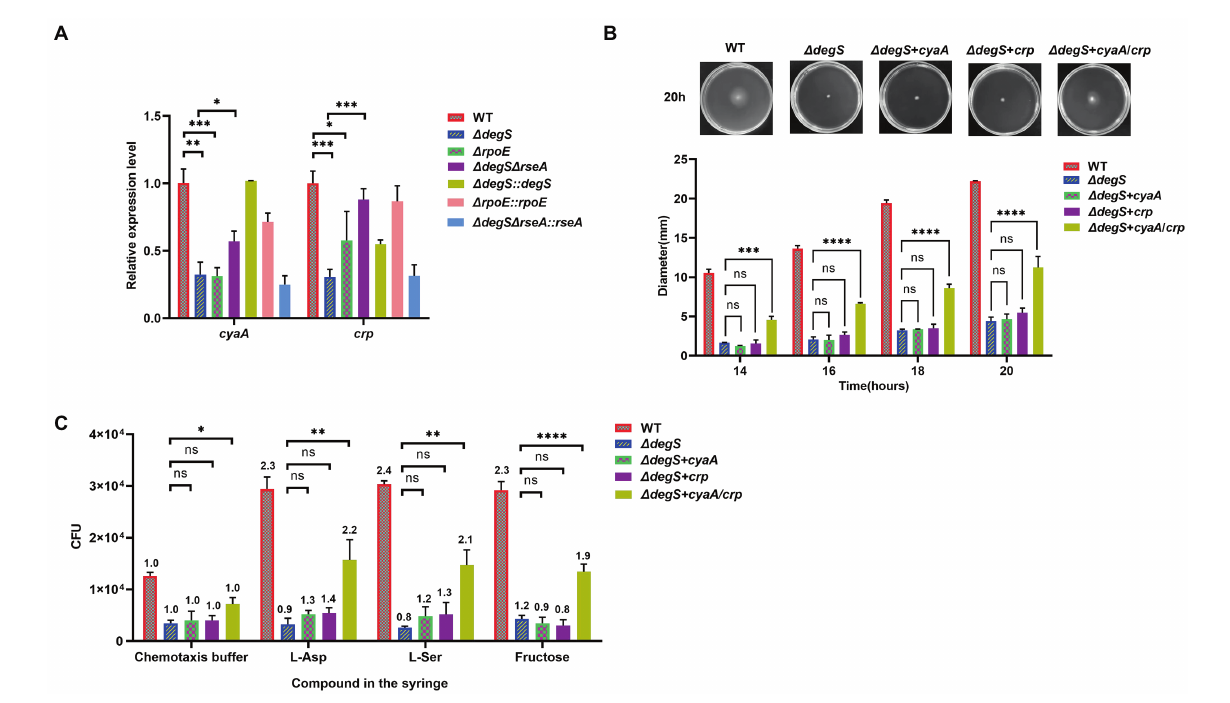
FIGURE 2 The regulation of Vibrio cholerae motility by DegS may involve the co-regulation of cAMP and CRP. (A) The mRNA levels of cyaA and crp in the WT, Δ degS , Δ degS::degS , Δ rpoE , Δ rpoE::rpoE , Δ degS Δ rseA , and Δ degS Δ rseA::rseA strains. Statistical analyses were performed using an unpaired t -test. *, p < 0.05; **, p < 0.01; and ***, p < 0.001 between two strains. (B) The swimming motility of WT, Δ degS , Δ degS + crp , Δ degS + cyaA and Δ degS + cyaA / crp strains was determined. The representative pictures for the swimming zones are obtained at 20 h. Statistical analyses were performed using a two-way ANOVA. ***, p < 0.001 and ****, p < 0.0001 between two strains; ns, not significant. (C) Analysis of the chemotactic responses to aspartate, serine, and fructose for the WT, Δ degS , Δ degS + crp , Δ degS + cyaA , and Δ degS + cyaA / crp strains. Error bars indicate the SDs based on three replicated experimental values (n = 3). *, p < 0.05; **, p < 0.01; and ****, p < 0.0001 between two strains; ns, not significant (unpaired t -tests). Numbers on top of each bar indicate the relative chemotactic indexes